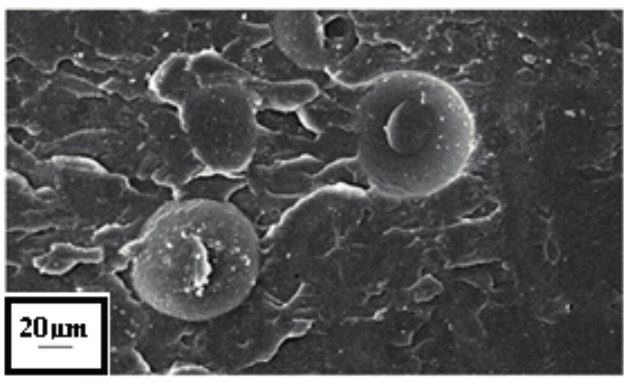
Figure 7. SEM micrograph showing crack propagation in PMMA/5 wt% Al 2 O 3 nanocomposite.